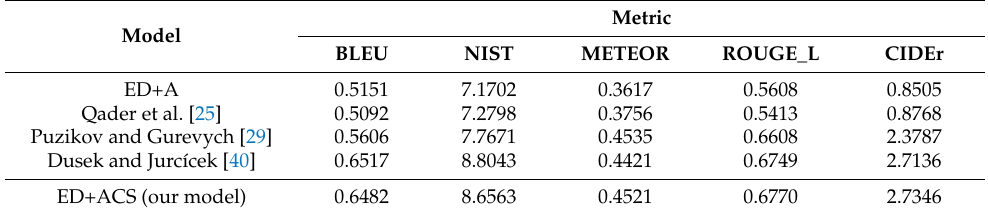
Table 4. Performance comparison on the E2E-NY test